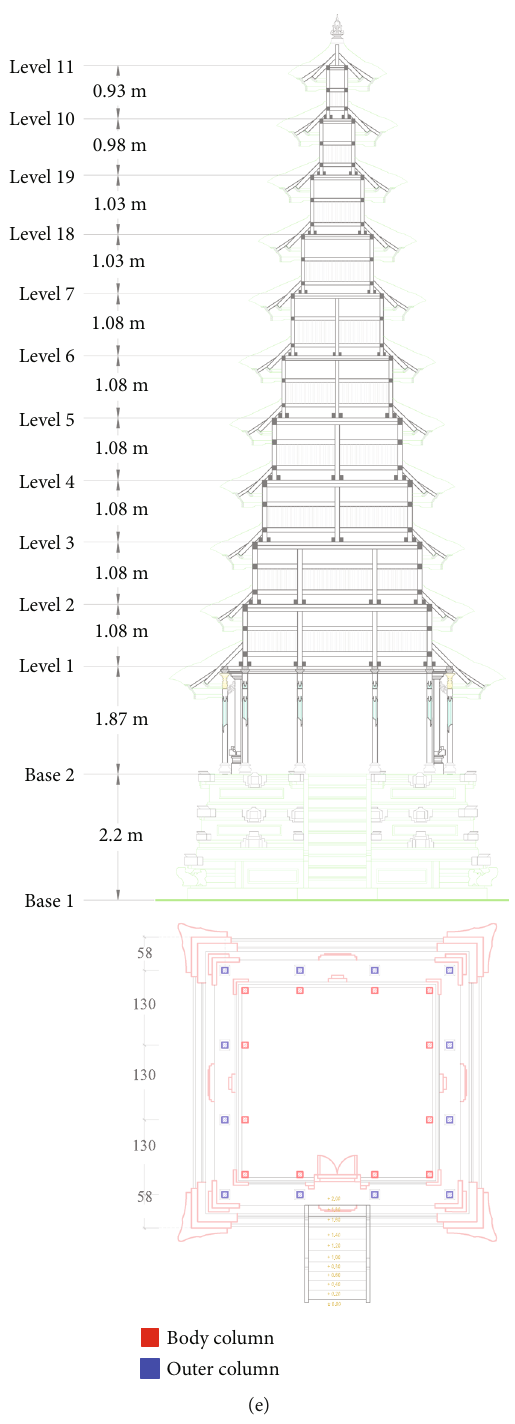
Figure 2: Plan and section of the Meru with 3, 5, 7, 9, and 11 overlapping